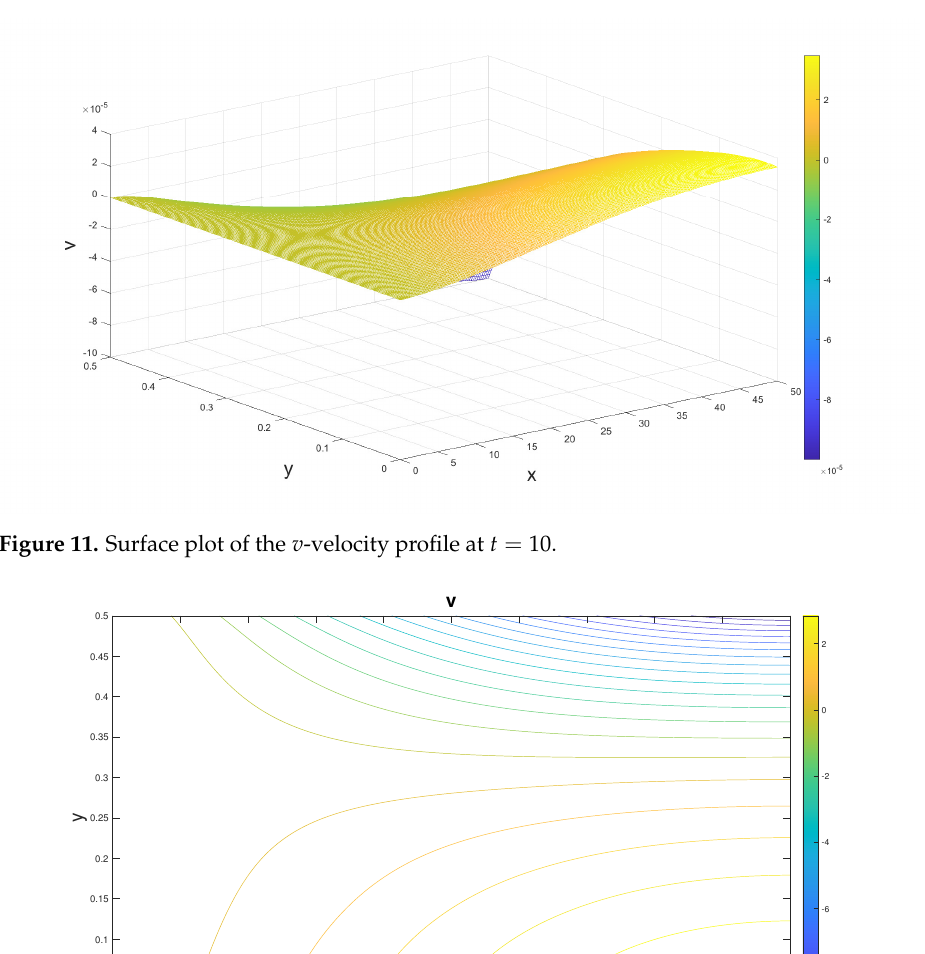
Figure 10. Contour plot of the u -velocity profile at t = 10.